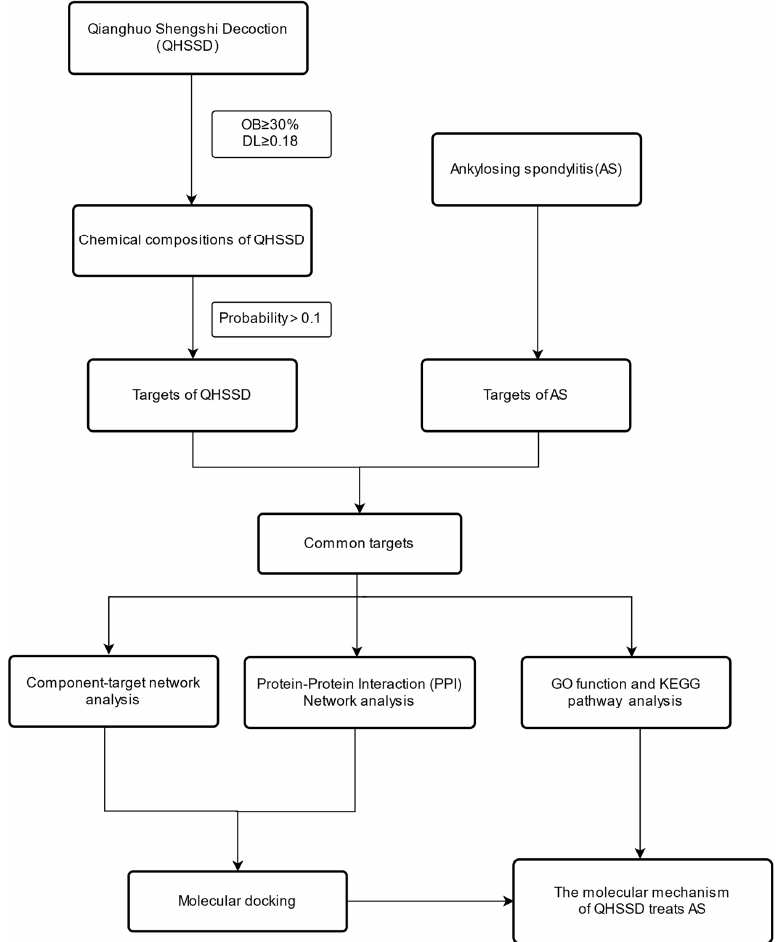
Figure 1. The workflow of the network pharmacology study of QHSSD for AS. Steps mainly in- cluded search and screening of potential targets, construction of protein–protein interaction net- work and component–target network, GO function and KEGG pathway analysis, and molecular docking validation.